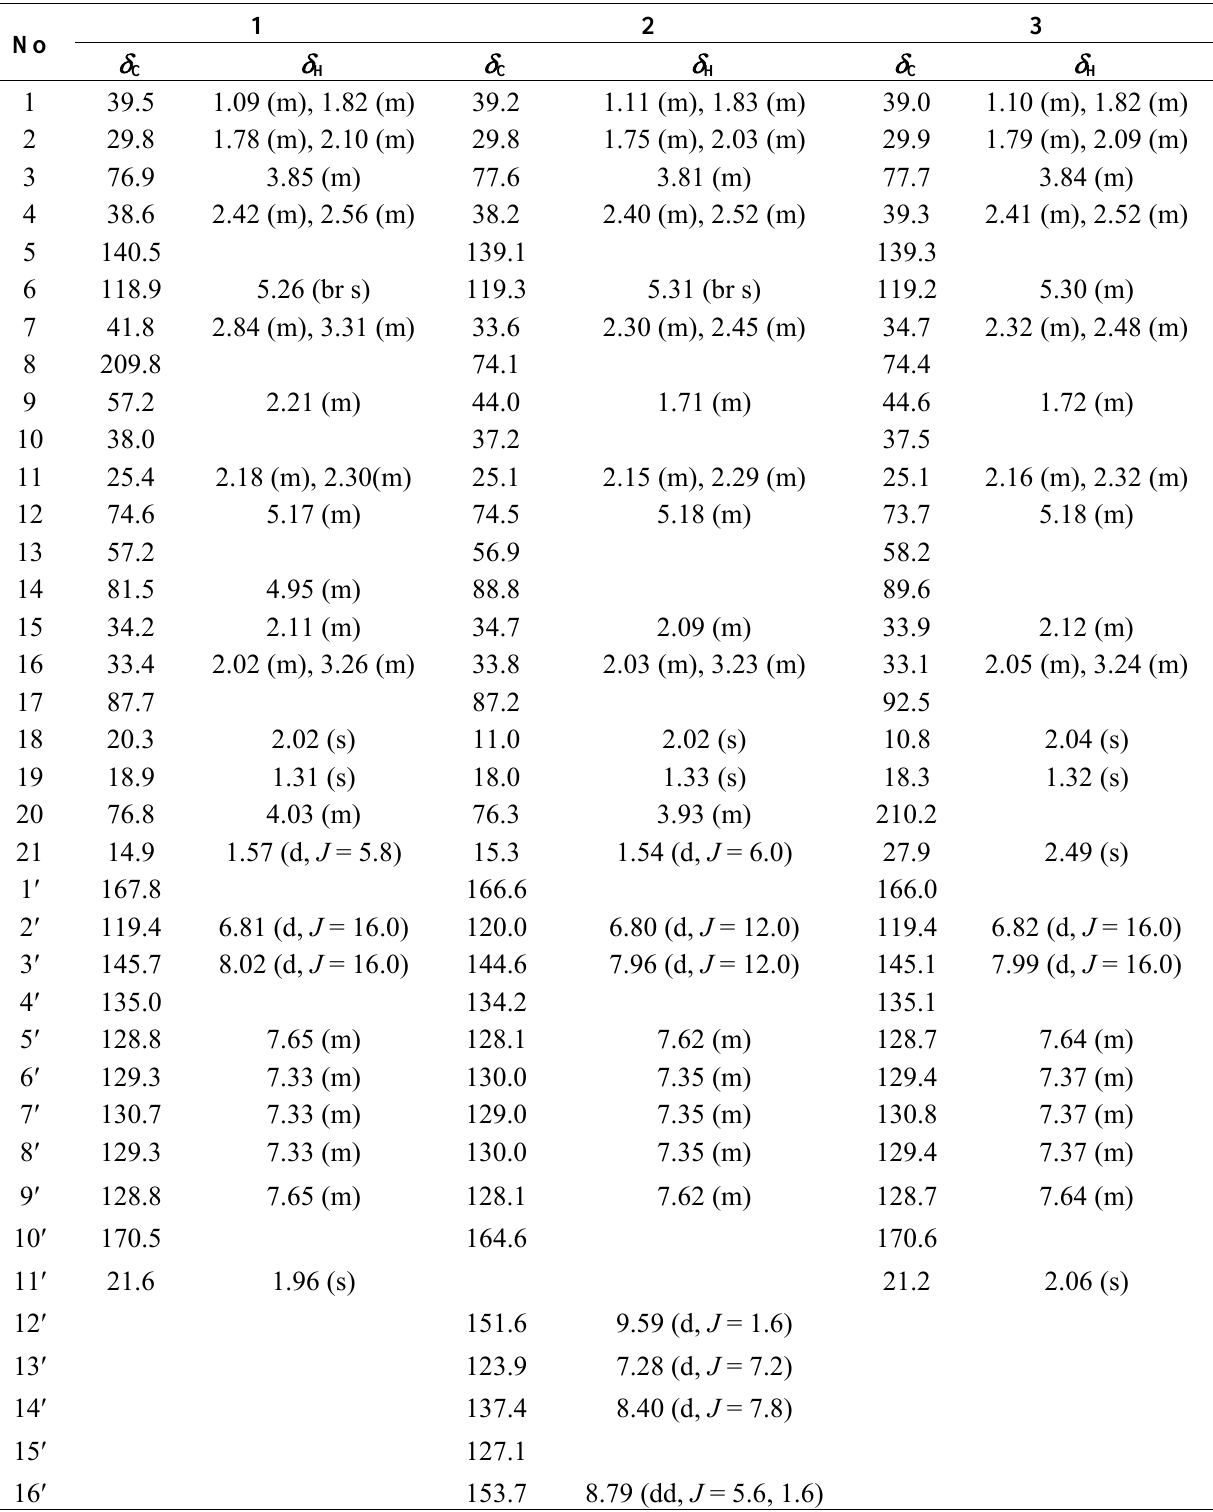
Table 1. NMR data of the aglycone moieties of compounds 1-3 δ in ppm, J in Hz.